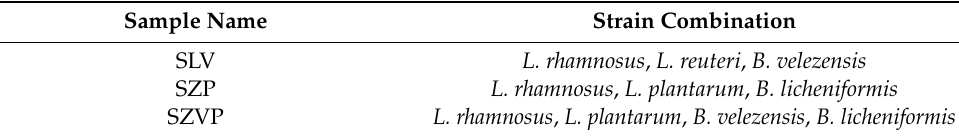
Table 4. Di ff erent combinations of microbial strains used in the